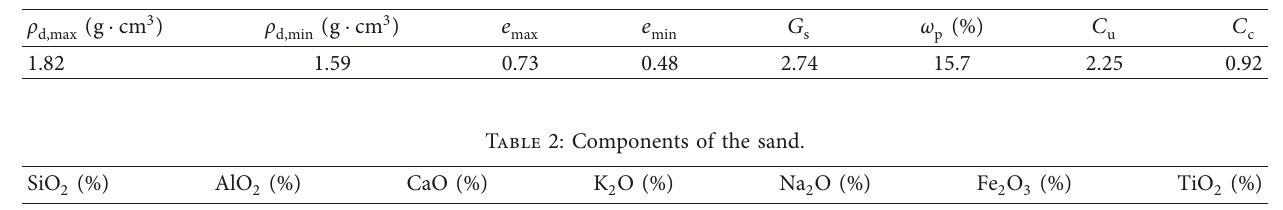
Table 1: Basic physical parameters of sand.